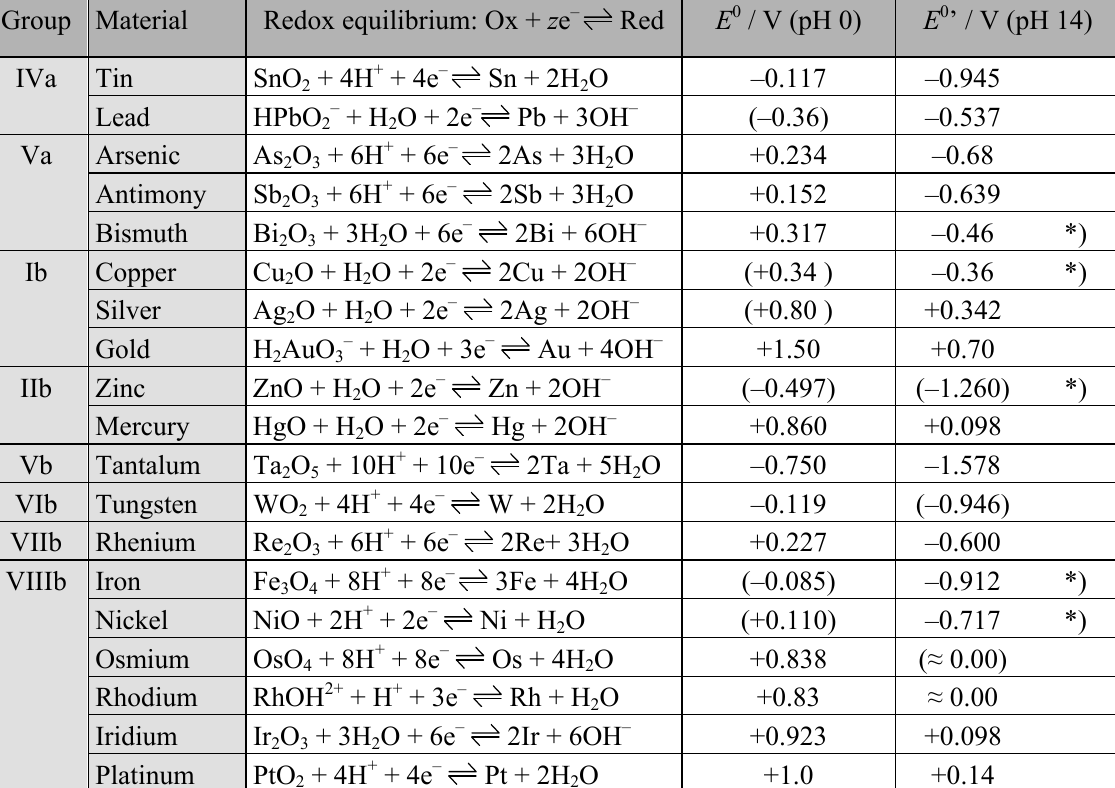
Table 4. Metal-metal oxide electrodes with pH dependent potentials. Metals having a standard potential E 0 < 0 V dissolve in aqueous solution. Values in parentheses denote unstable oxides at these conditions. *) In alkaline solutions, hydroxides are